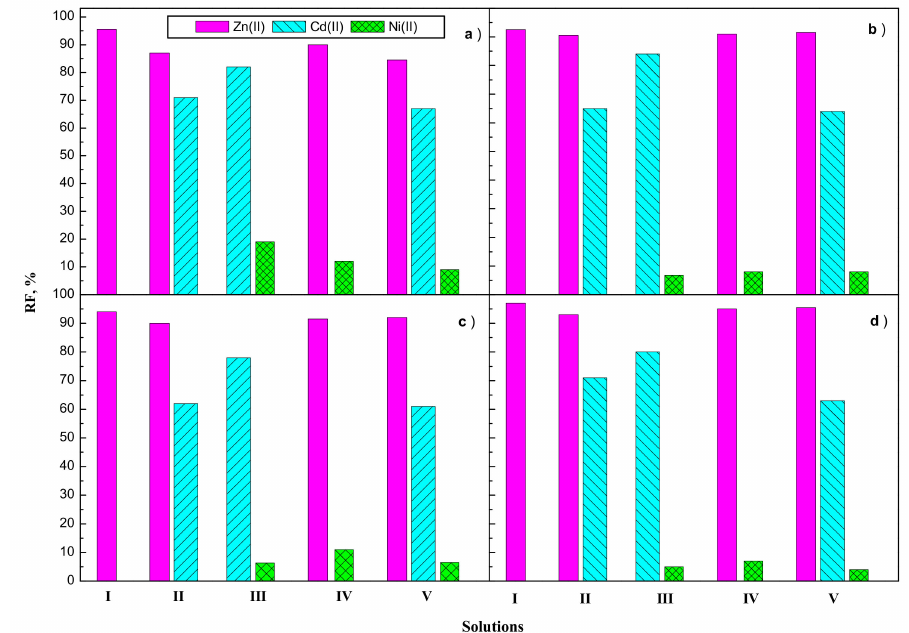
Figure 4. Recovery factors (RF) of Zn(II), Cd(II), and Ni(II) competitive transport across PIM doped alkylimidazoles 1 ( a ), 2 ( b ), 3 ( c ), and 4 ( d